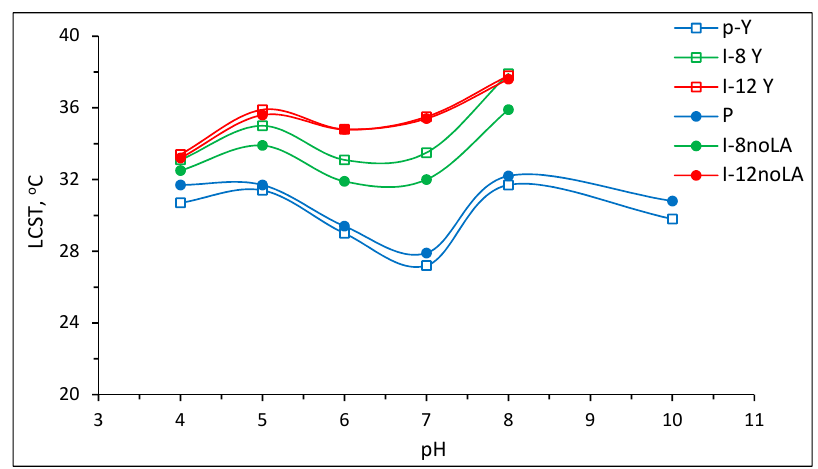
Figure 9. Determined lower critical solution temperature (LCSTs) (°C) of Pnipam and P(nipam-co-IAM) in various buffer solutions of pH = 4~10.